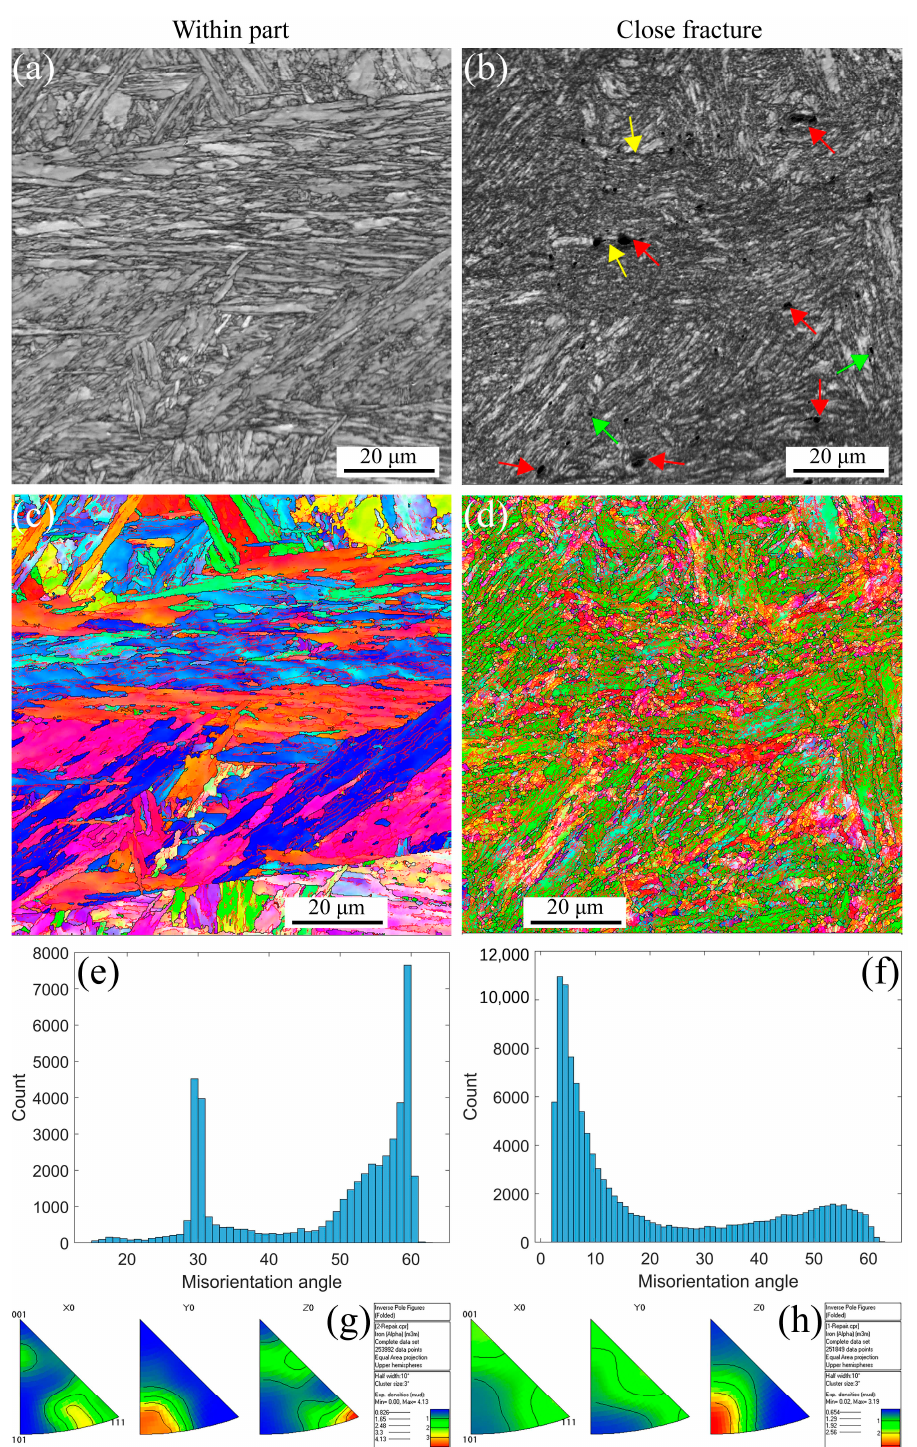
Figure 4. EBSD maps under different strain gradients at the strain rate of 5 × 10 − 3 s − 1 under RT (Red arrows indicate voids within the grain and along the line, green arrows indicate shrinking microstructures, and yellow arrows point to voids and shrinking cracks). ( a , b ) IQs; ( c , d ) IPFs; ( e , f ) misorientation angles; and ( g , h ) inverse polo